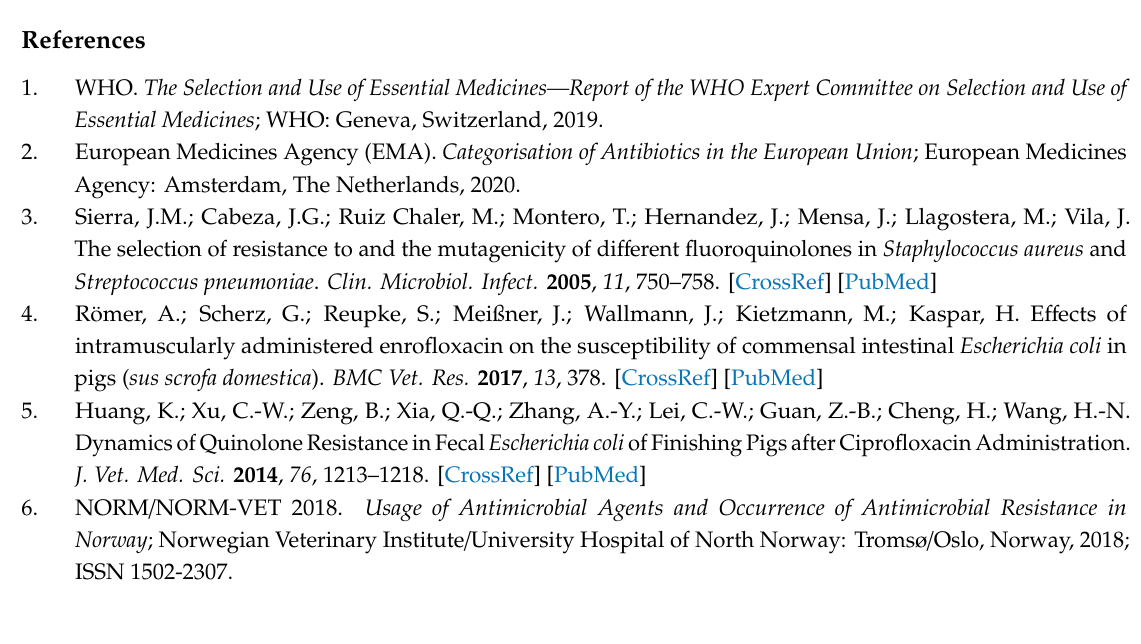
Table S1: Results from Chi-square tests for case versus control for each age group, Table S2: Resistance patterns among the 130 QREC isolates, Table S3: Overview of the relative amount of bacteria detected if growth at the respective dilution. Figure S1: Distribution of the log10-transformed